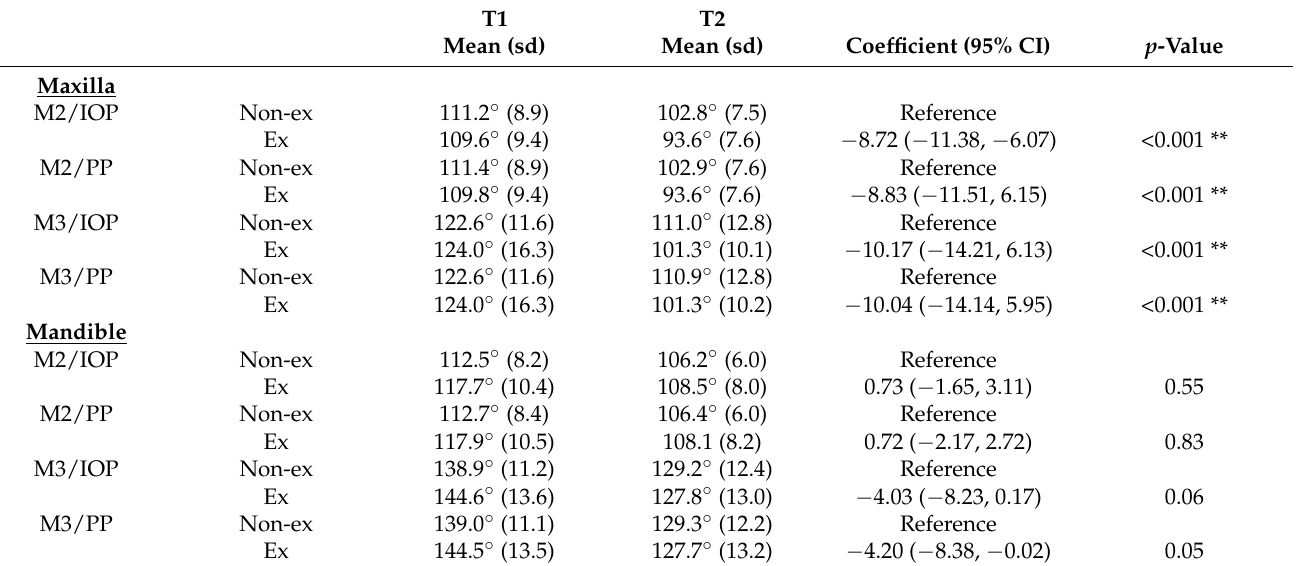
Table 2. Angular measurements in maxilla and mandible, adjusted treatment effects at T2, 95% confidence intervals, and p -values for the angular measurements per measurement and jaw.